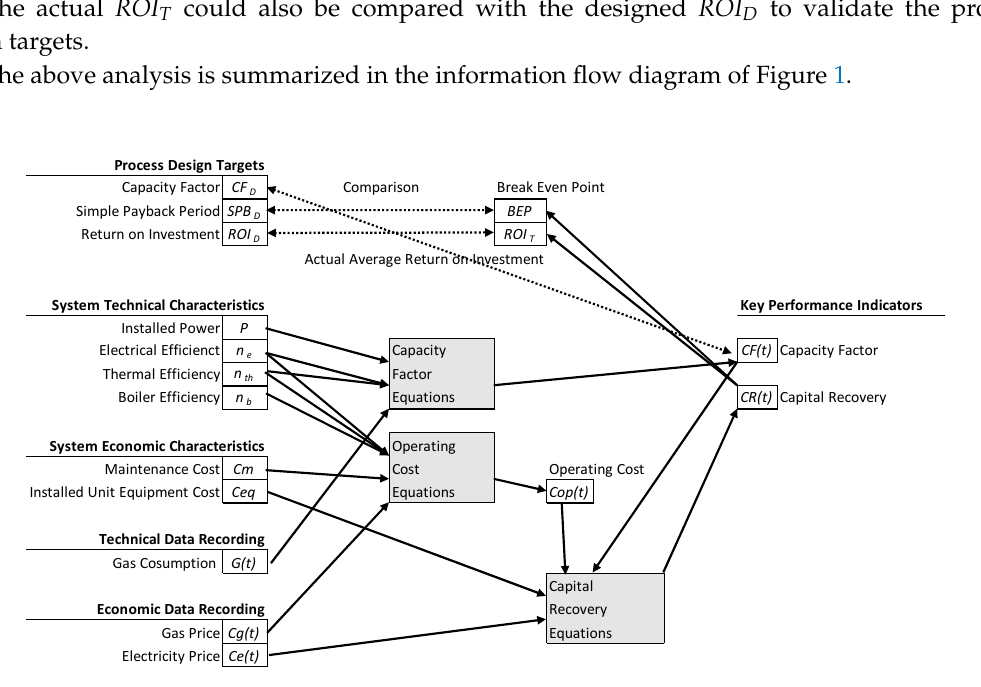
Figure 1. Information flow diagram of the selected key performance indicators (KPIs).